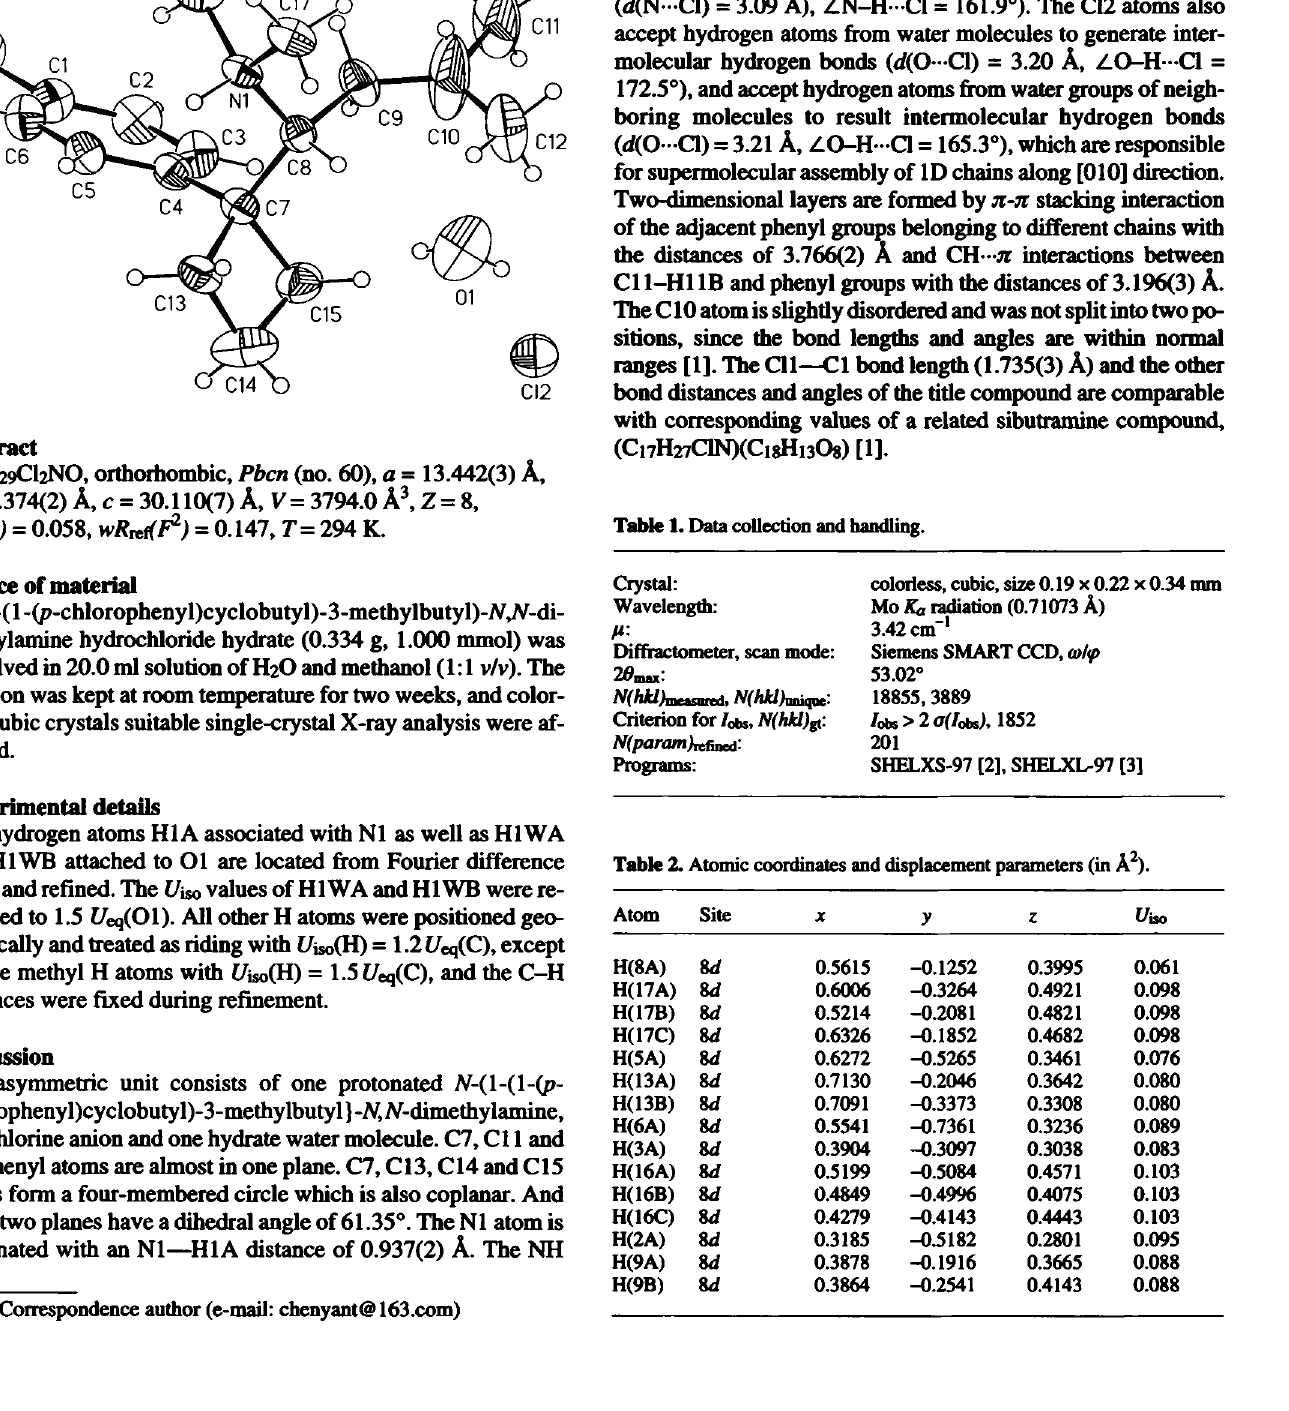
Table 2. Atomic coordinates and displacement parameters (in A 2